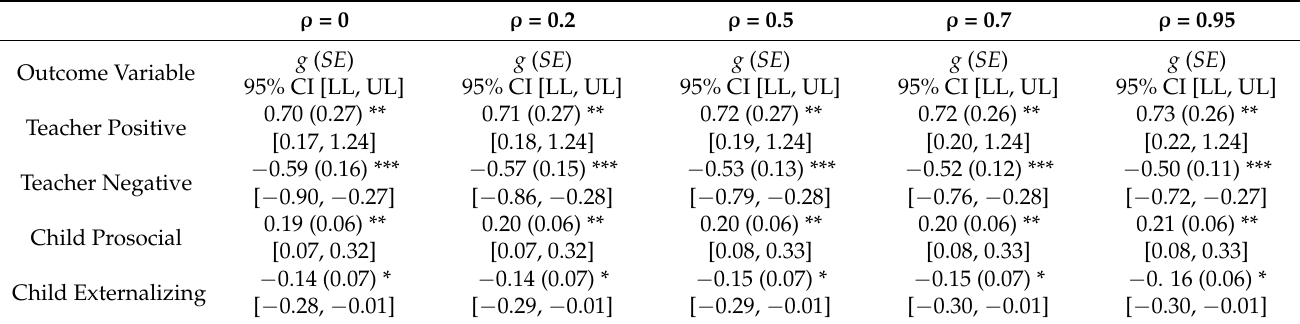
Table 2. Effect size results of Teacher and Child